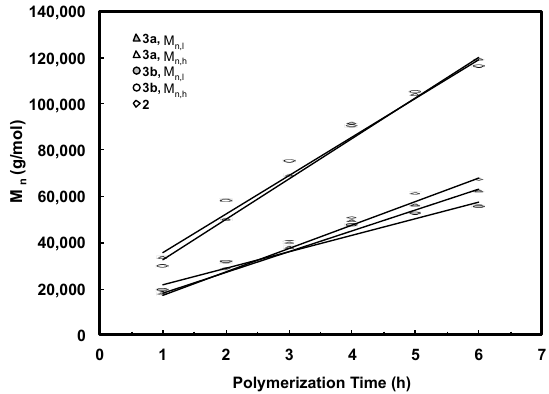
Figure 7. Number-average molecular weight of deconvoluted peaks as a function of polymerization time for polymers produced with catalyst 3a and 3b under 5 ◦ C and 400 psi. Comparison is made with polymers prepared using catalyst 2